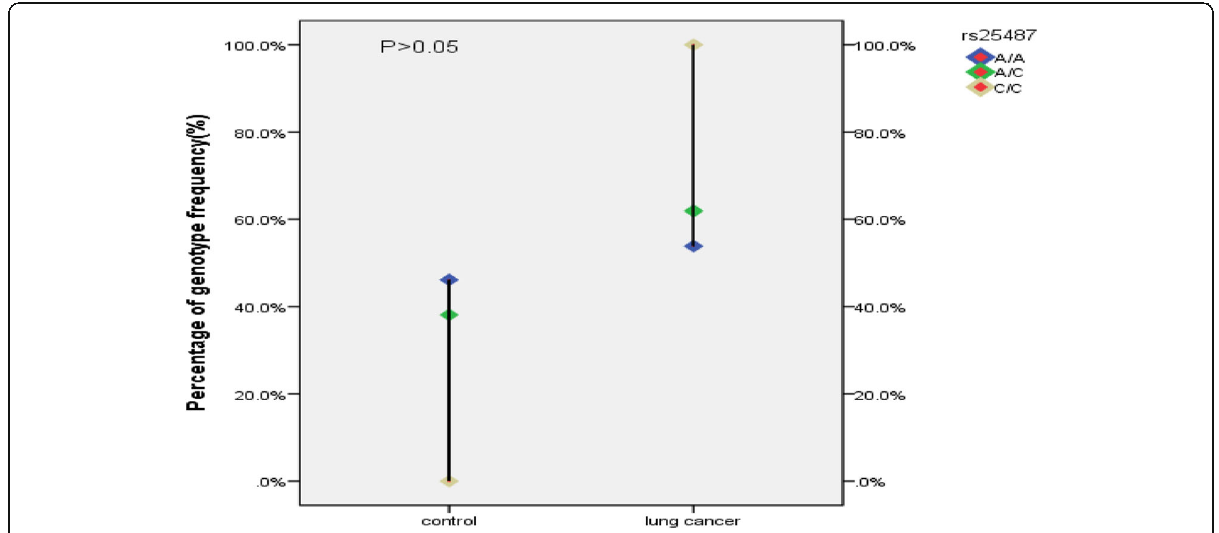
Fig. 2 Percentage of rs25487 genotypes frequency in lung cancer patients and